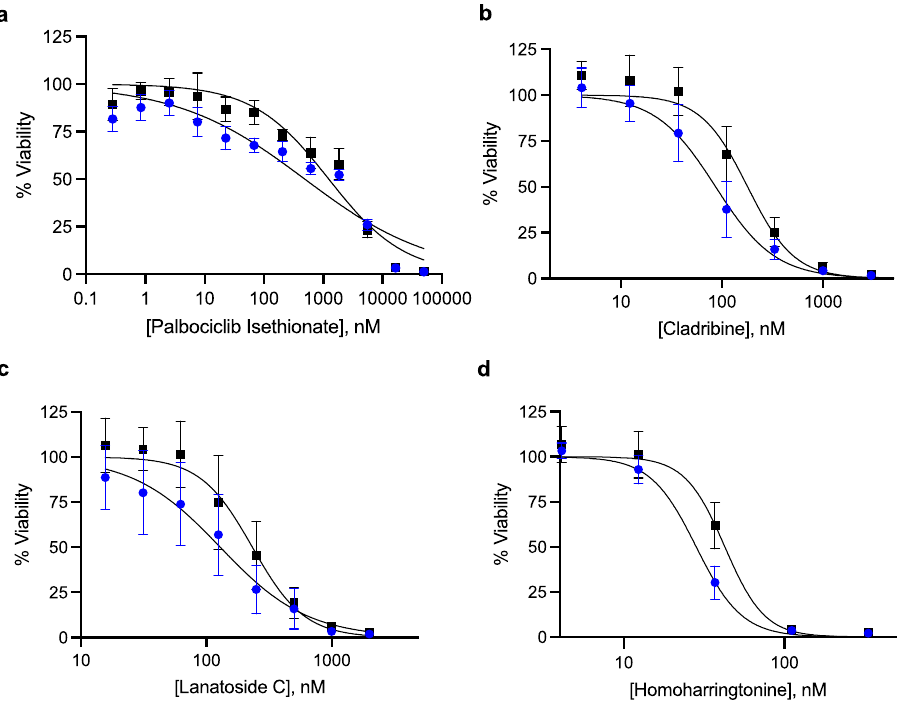
Figure 2. Drugs more cytotoxic towards CREB3L1-deficient HCC1806 cells (blue) as compared to CREB3L1 re-expressing HCC1806 + HACREB3L1 cells (black). Cells were plated and after 24 h were treated with the indicated concentration of drug, or solvent control, for 4 days. Solvents (max 0.4%) had little or no effect on the cell growth/number. Cells were stained, imaged and counted. Cell viability (%) was calculated as (# live cells in experimental well)/(# live cells in solvent control well)*100. Mean % viability ± SEM from triplicate measurements from at least 3 independent experiments. ( a ) Palbociclib Isethionate, 1:3 serial dilutions for concentrations 0–50 μM. ( b ) Cladribine, 1:3 serial dilutions for concentrations 0–9 μM. ( c ) Lanatoside C, 1:2 serial dilutions for concentrations 0–2 μM. ( d ) Homoharringtonine, 1:3 serial dilutions for concentrations 0–333